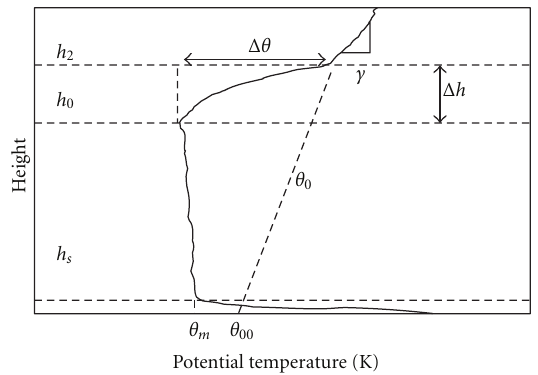
Figure 4: ABL Conceptual representation of the structure with the profile of potential temperature θ (Adapted from